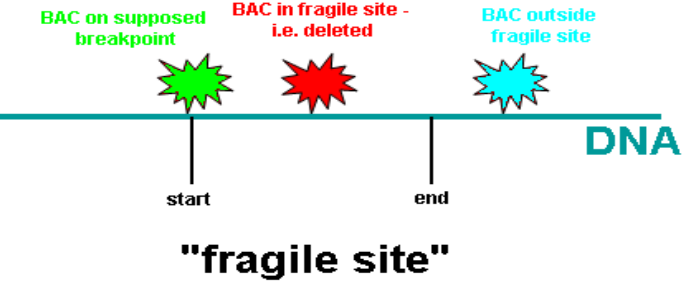
Figure 3. Different situations of FISH signals at a fragile site. The boundary of a fragile site was defined by FISH analysis probed with a series of labeled BAC clones. A fragile site consists of colocalized BAC DNA regions on supposed breakpoint and inside fragile site.